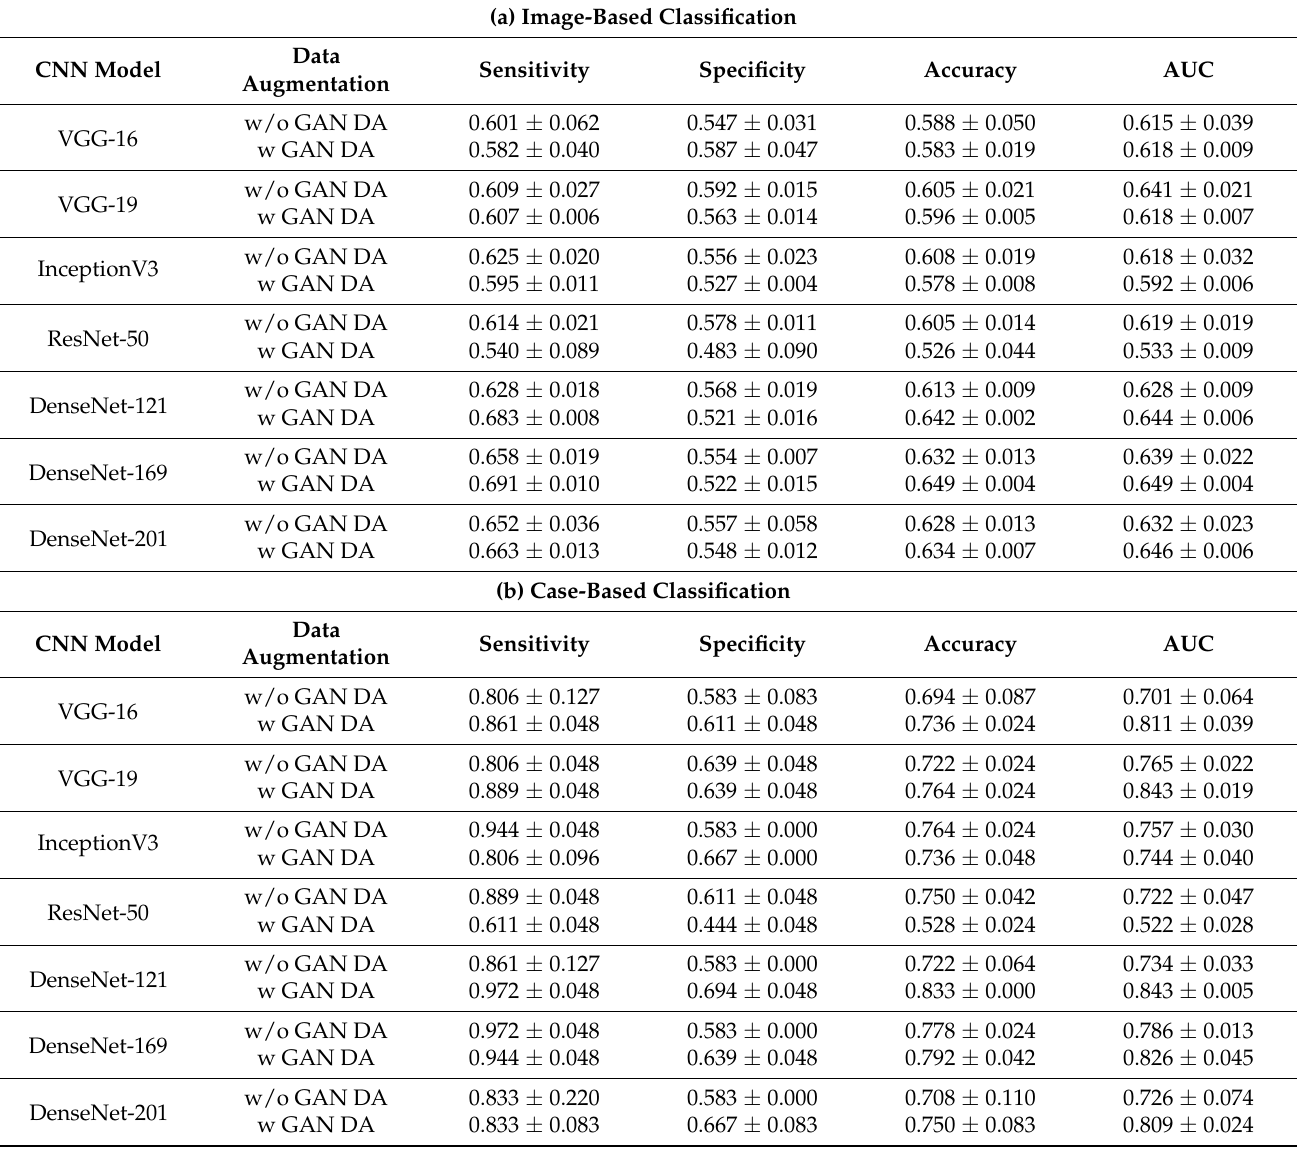
Table 1. Performance evaluation. (a) Image-Based Classification